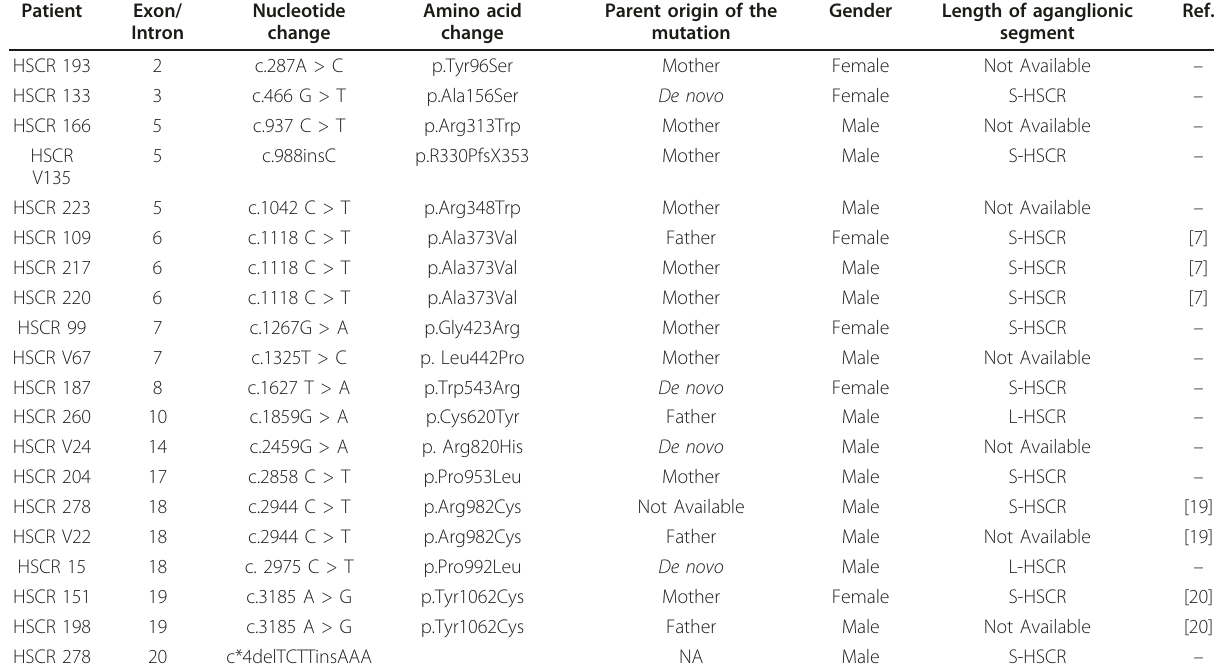
Table 1 RET germline mutations identified in our series of HSCR patients Patient